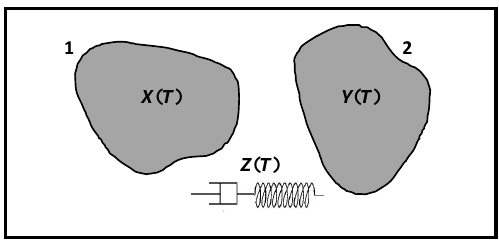
Figure 1. The fault model. The state of the fault is described by the slip deficits X(T ) and Y(T ) of the asperities and by the viscoelastic deformation Z(T )